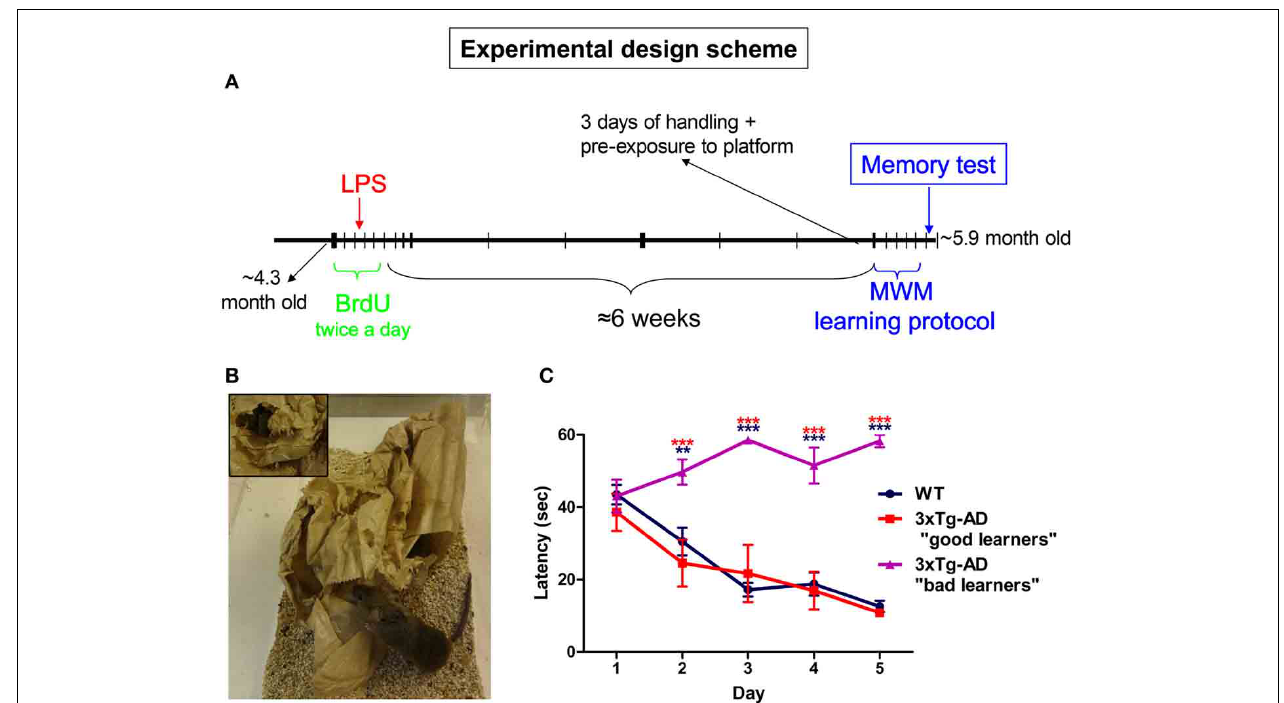
FIGURE 1 | Experimental design. (A) 5-bromo-2 (cid:3) -deoxyuridine (BrdU) was administered (100mg/Kg) intraperitoneally for 5 days (twice per day with 8h interval). On day third of BrdU treatment animals received a single intraperitoneal injection of saline (PBS) or 1mg/Kg of LPS. Six weeks after last BrdU injection all mice were submitted to MWM training and test protocol.